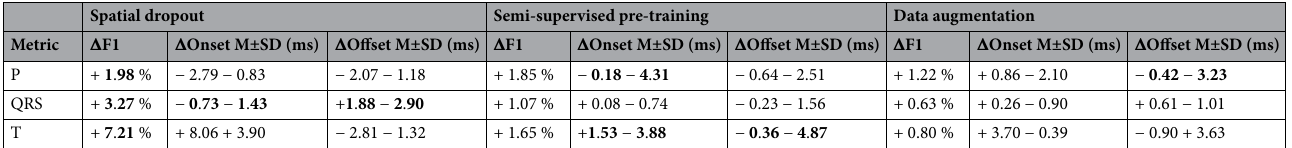
4.55 ± 31.11 ms in the offset for delineation, with Dice scores of 88.99%, 92.05%, 88.40% for the P, QRS and T waves, respectively. This model was used to predict some registries in 19 , shown in Supplementary Figs. S1–S10. The best multi-lead model features 4 levels and 6 blocks per level employing the “XCeption” convolutional block, reaching P, QRS and T precisions of 94.17%, 99.40% and 96.36% and recalls of 94.70%, 99.28% and 99.09% for detection. The delineation performance deviated from the ground truth 1.54 ± 22.89 ms, 1.54 ± 22.89 ms and 1.54 ± 22.89 ms in the onset and 4.01 ± 16.08 ms, 5.39 ± 16.77 ms and 9.93 ± 46.33 ms in the offset, reaching Dice scores of 88.19%, 92.14%, 89.33% for the P, QRS and T waves, respectively. The optimal network configuration for both single- and multi-lead is detailed in Table 2, whereas Figs. 5, 6 and 7 depict several samples from the single-lead and multi-lead approaches. Inter‑observer and intra‑observer bias. The comparison of the different sources of bias within the data- base have been summarized in Table 3. The inter-observer bias shows larger or comparable bias for both single- and multi-lead scenarios in the QRS onsets (3.84 ± 14.17 ms vs. -0.07 ± 8.37 ms and -3.83 ± 14.64 ms) and offsets (2.74 ± 16.94 ms vs. 3.64 ± 12.55 ms and 5.39 ± 16.77 ms). The T wave is generally delineated more precisely by the human operator in its onsets (-9.52 ± 44.85 ms vs. 21.57 ± 66.29 ms and 19.10 ± 66.51 ms) and offsets onsets